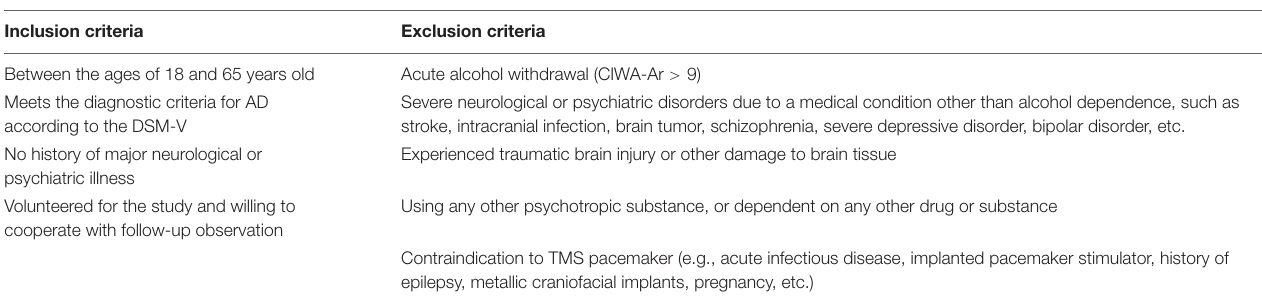
TABLE 1 | Study inclusion and exclusion